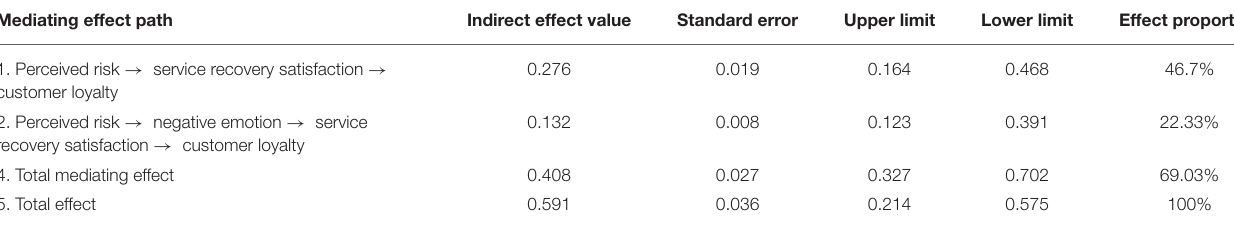
TABLE 7 | Test results of mediating